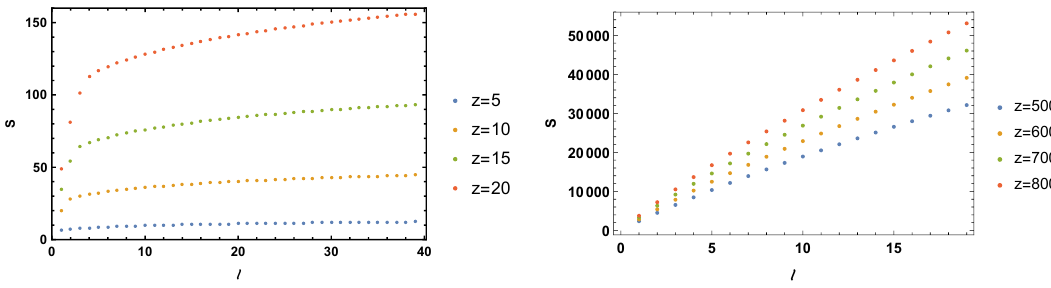
Figure 2 . EE as a function of ‘ for di(cid:11)erent values of z . Here we consider Dirichlet boundary condition for a massless scalar with N = 500 (left) and N = 20000